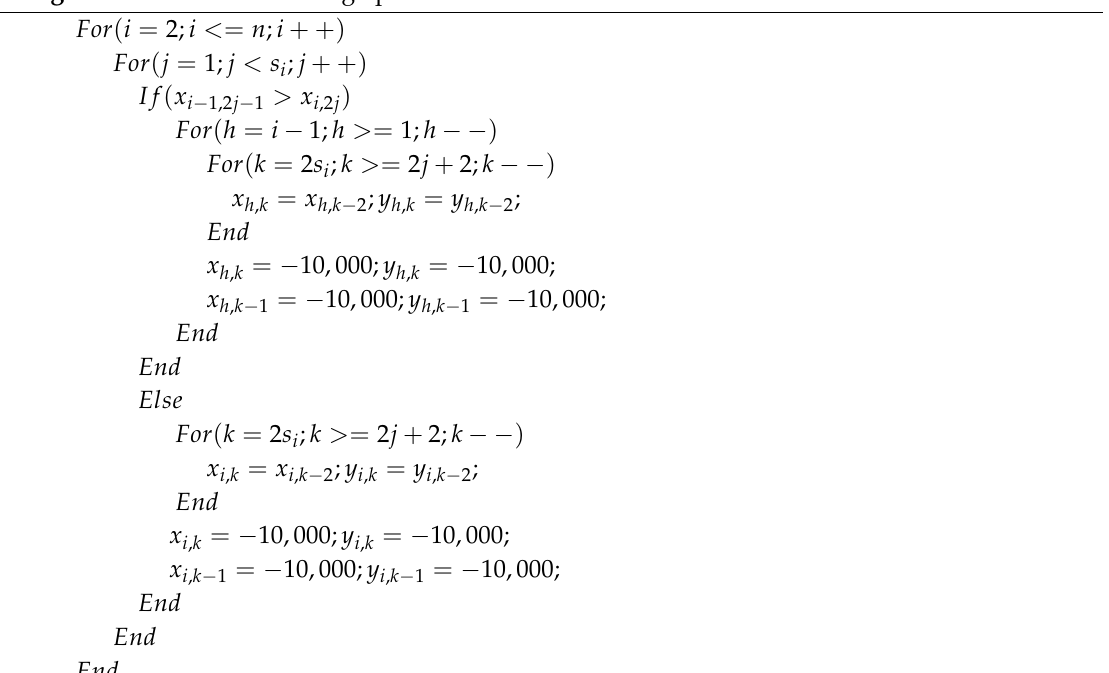
Algorithm 1: Position-shifting operations for P